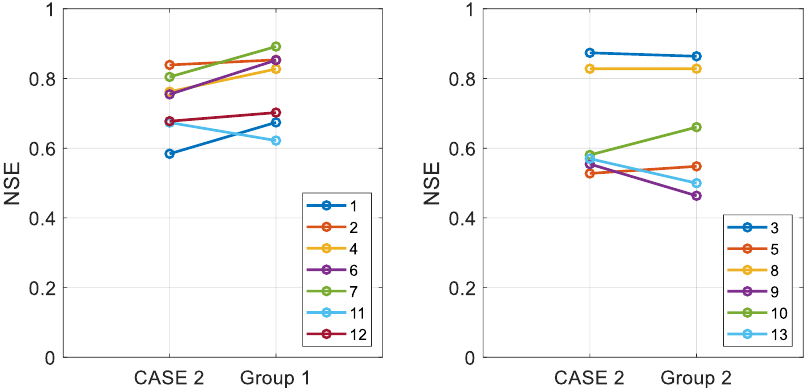
Figure 11. Comparison of NSEs for the LSTMs integrally learned considering a basin characteristic (Groups 1 and 2) and the LSTM integrally learned for the entire basins in Section 3.2 (CASE 2). Here, Group 1 is a combination of basins with a relatively lower CN value, and Group 2 is a combination of basins with a relatively higher CN value.